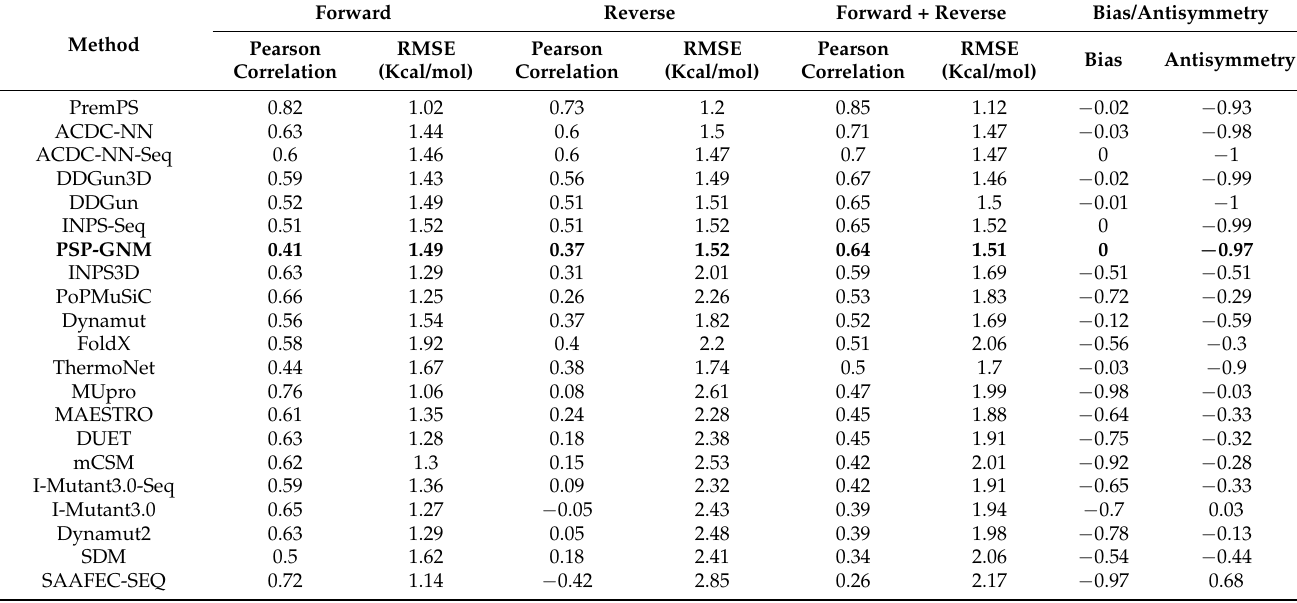
Table 8. Performance comparison on the Ssym+ dataset for a subset of 341 mutations with a PSP- GNM-calculated ∆∆ G. The table is sorted by Pearson correlation in the Forward + Reverse category. The performance for PSP-GNM is shown in